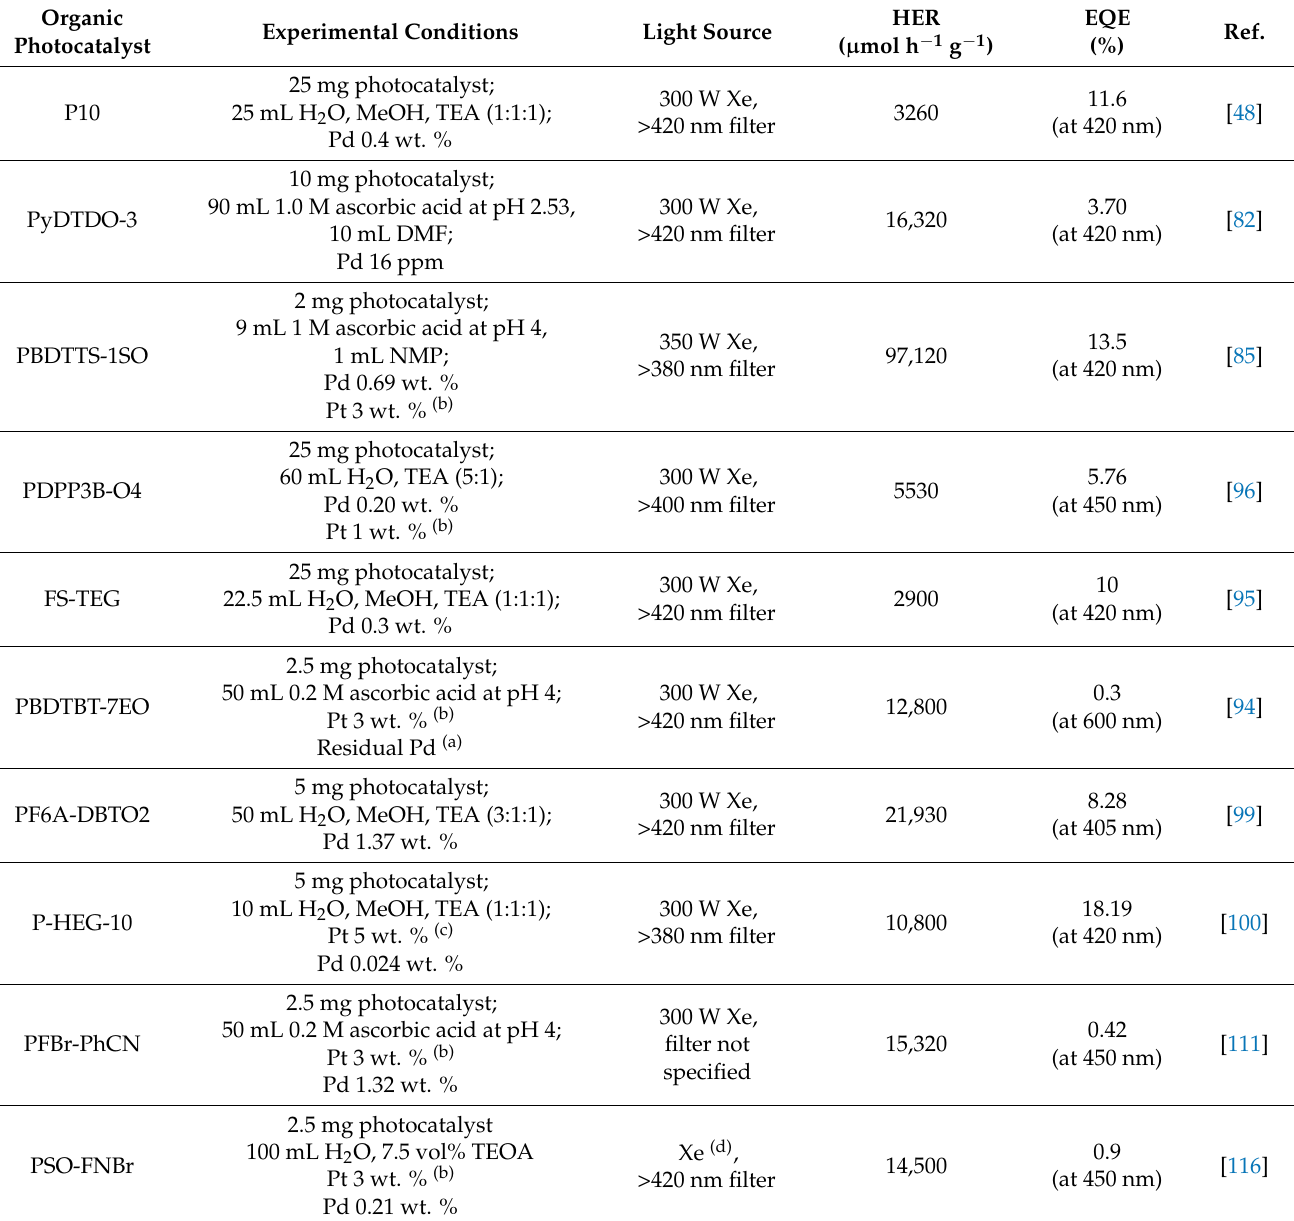
Table 1. Comparison of photocatalytic activity associated involving materials with polar cores and/or